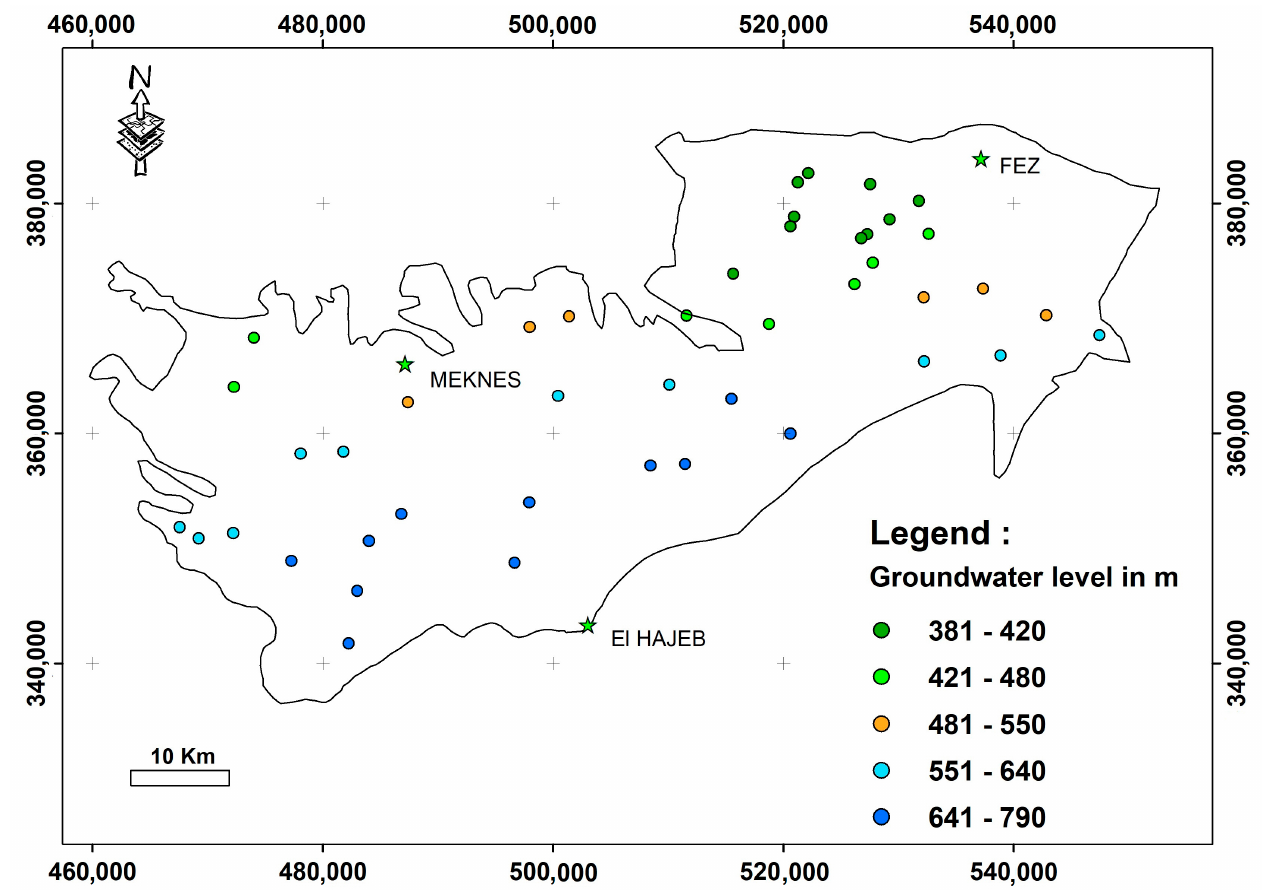
Figure 5 . Distribution map of used piezometers in 2020 . Figure 5. Distribution map of used piezometers in